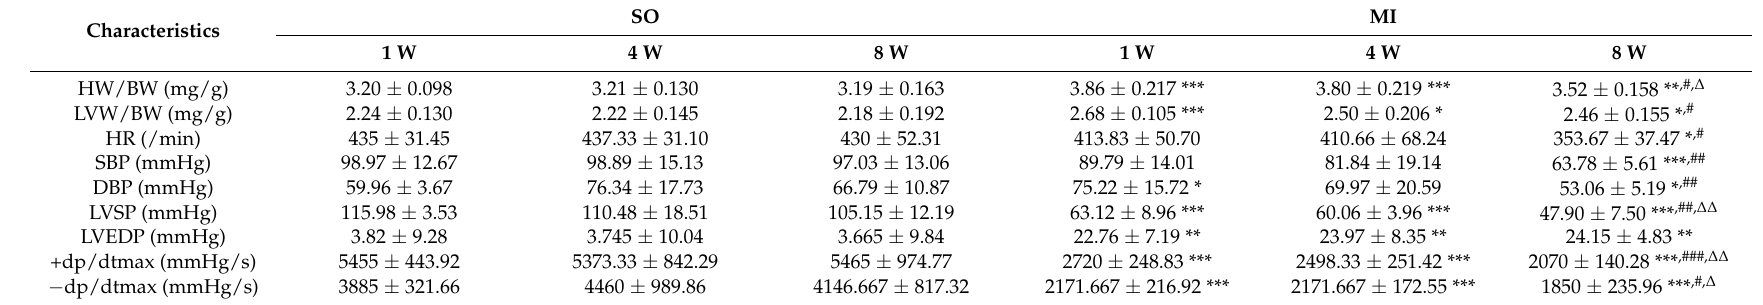
Table 2. Morphological and hemodynamic characteristics of rats. BW: body weight. HW: heart weight. LVHW: left ventricular heart weight. HR: heart rate. SBP: systolic blood pressure. DBP: diastolic blood pressure. +dp/dt: maximal rate of rise of blood pressure in ventricle chamber. − dp/dt: maximal rate of rise of blood pressure in ventricle chamber. LVESP: left ventricular end systolic pressure. LVEDP: left ventricular end diastolic pressure. * p < 0.05, ** p < 0.01, *** p < 0.001,